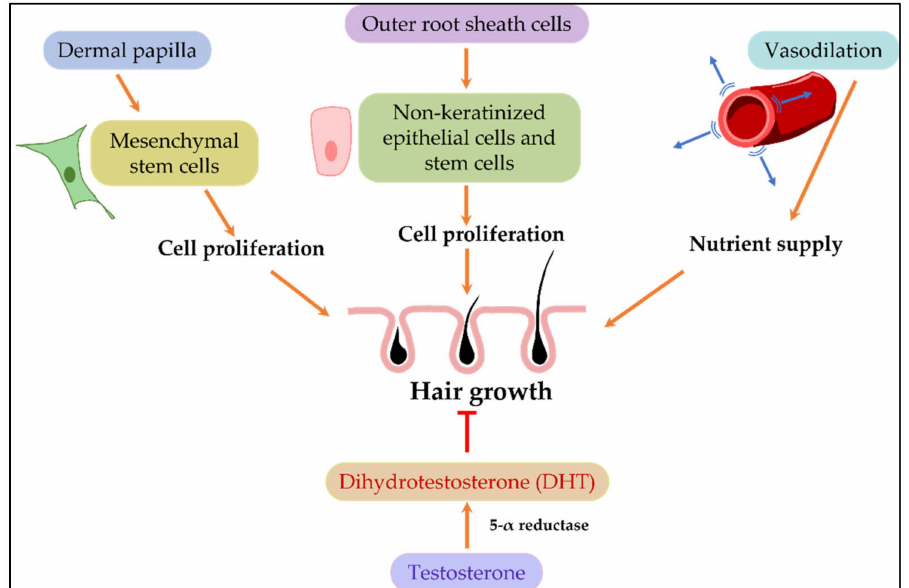
Figure 2. Key factors contributing for hair follicle growth. The proliferation of mesenchymal stem cells from dermal papilla and non-keratinized epithelial cells contributes to the growth of the hair follicles. Agents that can stimulate the growth of these cell types can be potential hair-growth promoters. The enzyme 5-alpha reductase converts testosterone into a more potent form, i.e., dihydrotestosterone (DHT), which has inhibitory effects on hair growth. Inhibiting this enzyme is one of the strategies for promoting hair growth. Finally, vasodilation facilitates nutrient supply to hair follicle cells and promotes hair